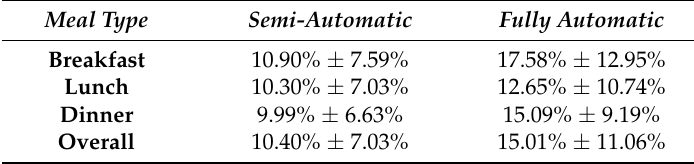
Table 3. Mean absolute errors for different meals for both semi- and fully automatic